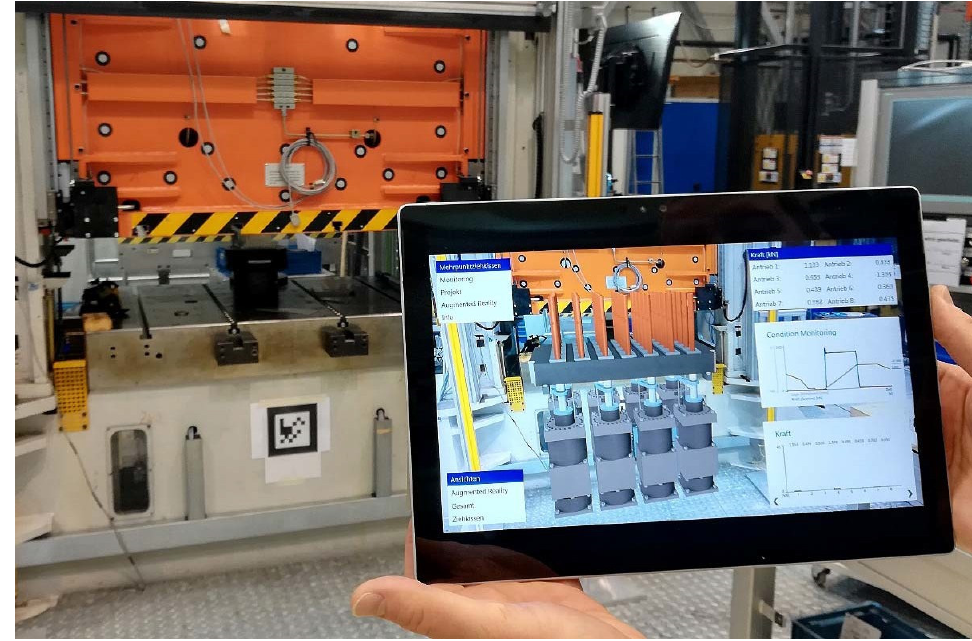
Figure 5. Augmented Reality visualization of the die cushion and online data on a tablet computer to support the operator in commissioning and monitoring.